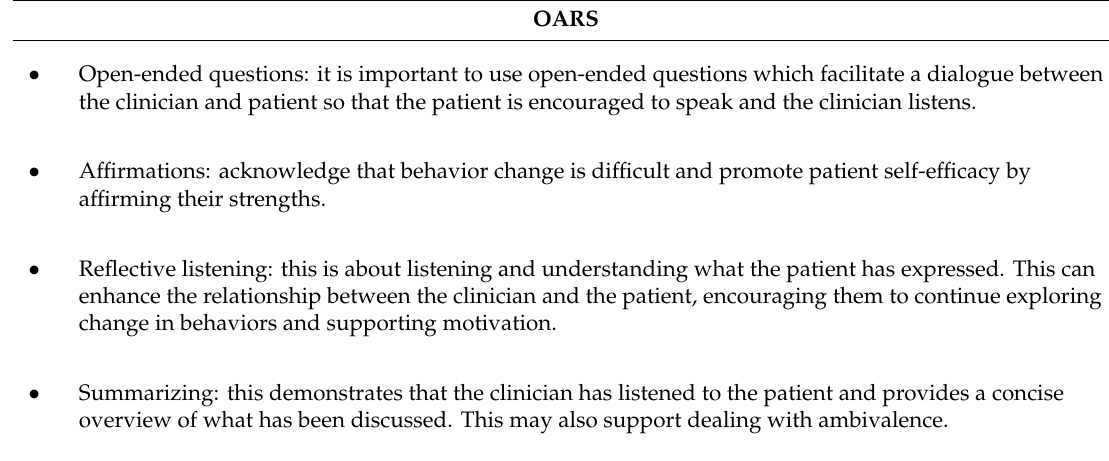
Table 1. Skills and methods used to communicate e ff ectively with patients